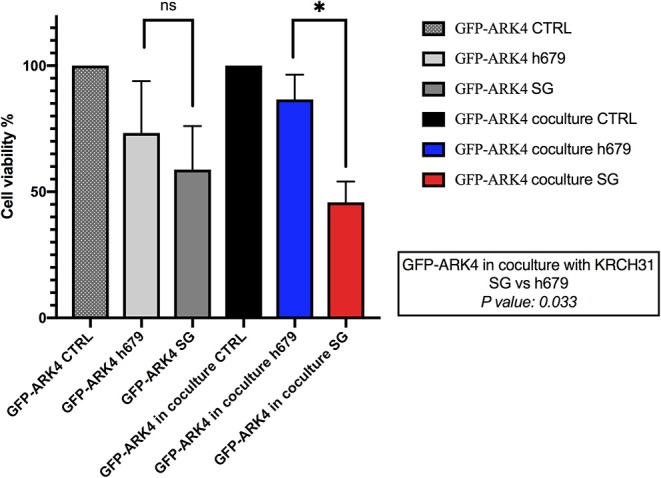
Bystander assay. Black bar: Low/negative Trop-2 expressing ARK4 cells (GFP-ARK4 cells), co-cultured without any treatment (control, CTRL). Blue bar: low Trop-2 expressing cells (GFP-ARK4 cells) co-cultured with high Trop-2 expressing cells (KRCH31), and treated with control ADC at 1 nM concentration. Red bar: low Trop-2 expressing cells (GFP-ARK4 cells) co-cultured in with high Trop-2 expressing cells (KRCH31), and treated with SG at 1 nM concentration. Significant increase in ARK4 cell cytotoxicity was detected with SG treatment only at the time of the co-incubation with KRCH31 cells (p < 0.05, *P ≤ 0.05, **P ≤ 0.01, ***P ≤ 0.001).